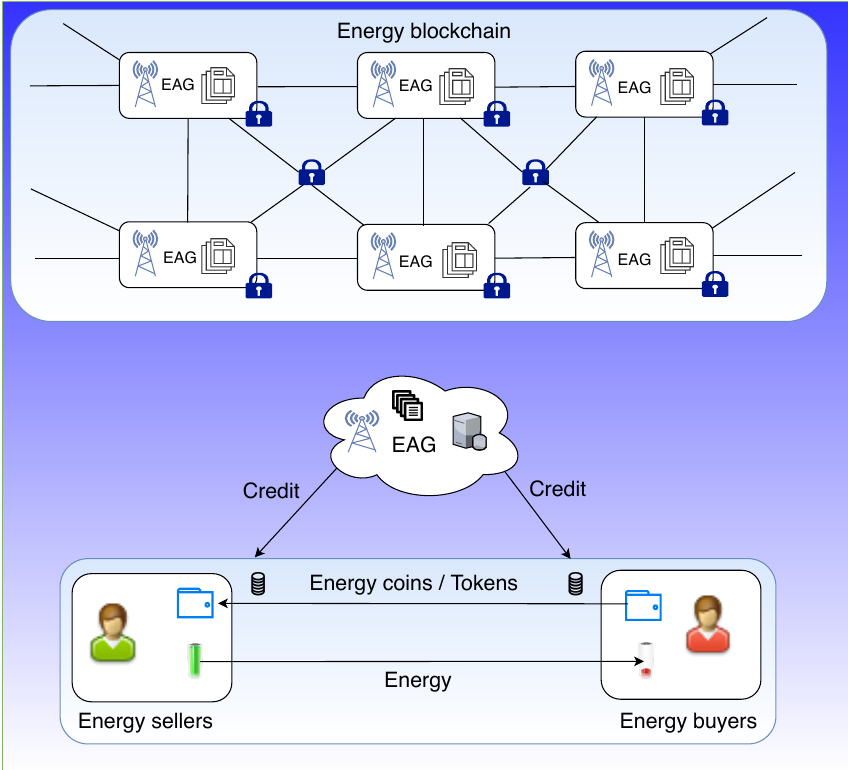
Figure 3. Architecture for P2P energy